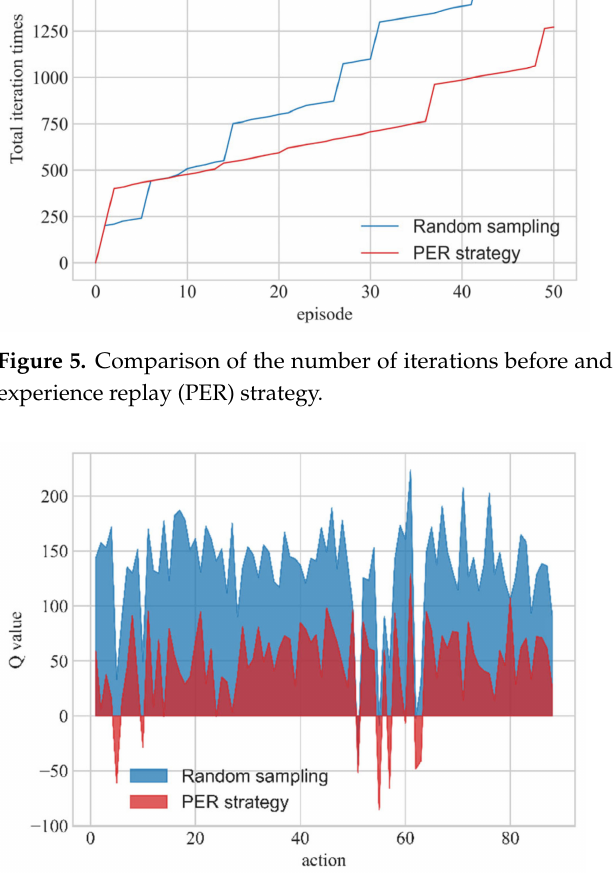
Figure 6. Comparison of the Q values under the two experience extraction strategies in the last